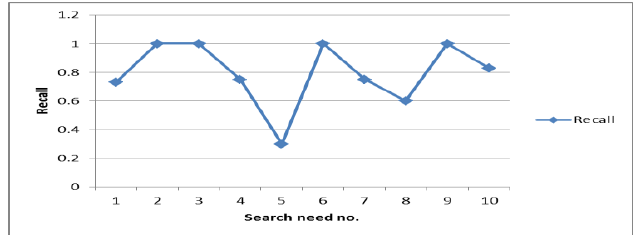
Fig. 13. Recall line graph of Law-Torch.